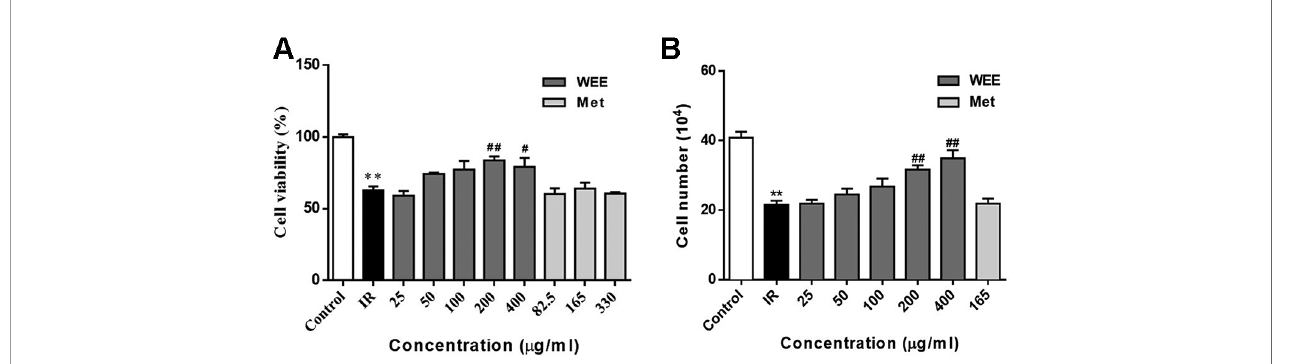
FIGURE 2 | WEE treatment increased the cell viability in PA treated HepG2 cells. HepG2 cells were incubated with normal glucose (5.5 mM) or high glucose (30 mM) with PA (0.3 mM) in the absence or presence of WEE (25 – 400 m g/ml) or metformin (82.5 – 330 m g/mL) for 24 h and followed by insulin (100 nM) incubation for 20 min. Cell viability was determined by the MTT assay. Results were expressed as percentages of control (A) . The total cell number was calculated by a hemocytometer (B) . Data presented in bar charts are mean ± SEM values from six independent experiments. Groups are signi fi cantly different from the control group at * p < 0.05, ** p < 0.01. The groups are signi fi cantly different from the IR group at # p < 0.05 and ## p < 0.01 determined by Dunnett ’ s multiple comparisons test.